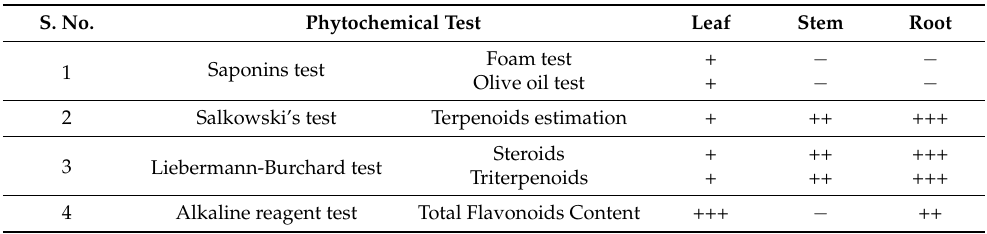
Table 1. Detection of phytochemicals in the leaf, stem, and root extracts using Saponins test, Salkowski’s test, Liebermann-Burchard test and Alkaline reagent test. The symbol (+) was used for presence and ( − ) for absence of phytochemicals during qualitative screening. S. No. Phytochemical Test Saponins test Salkowski’s test